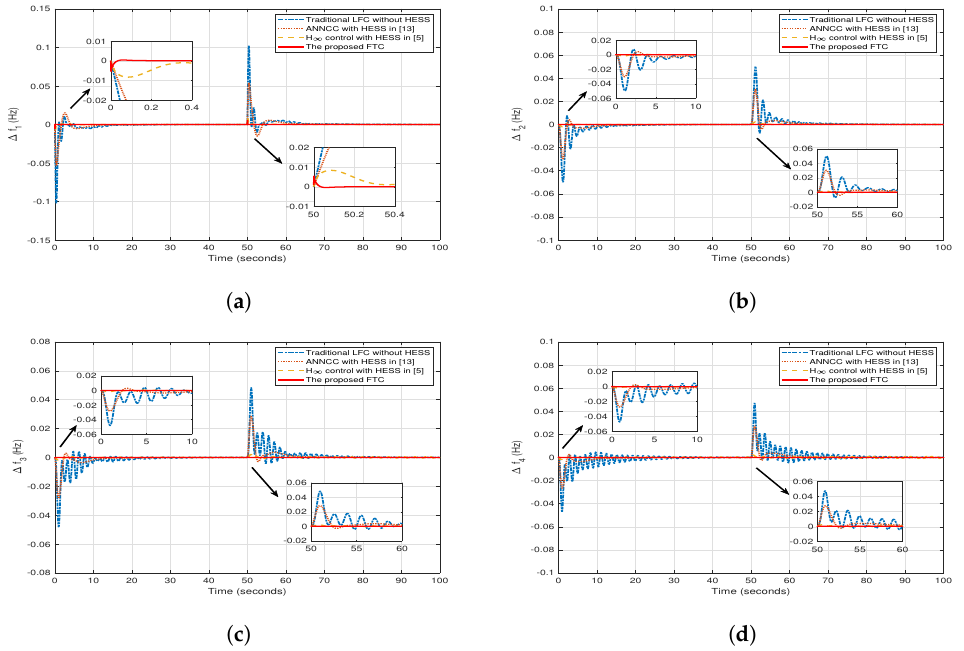
Figure 8. The frequency deviation of a four-area interconnected power system subjected to a lumped disturbance 0.02 p.u and another 0.015 p.u at time 50 s: ( a ) ∆ f 1 ; ( b ) ∆ f 2 ; ( c ) ∆ f 3 ; ( d ) ∆ f 4